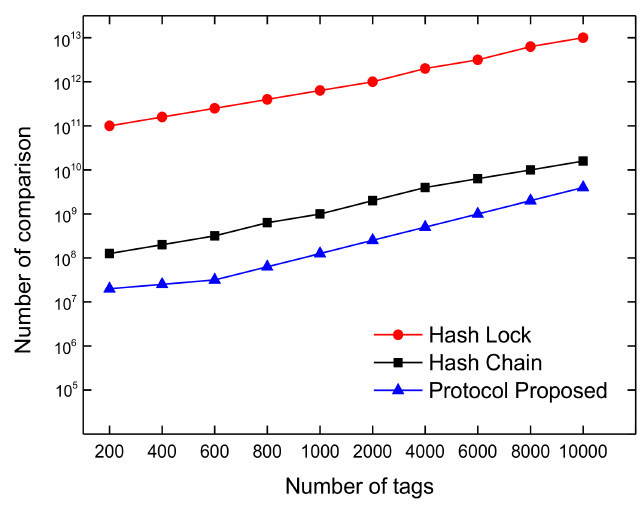
Figure 4. The number of comparison in